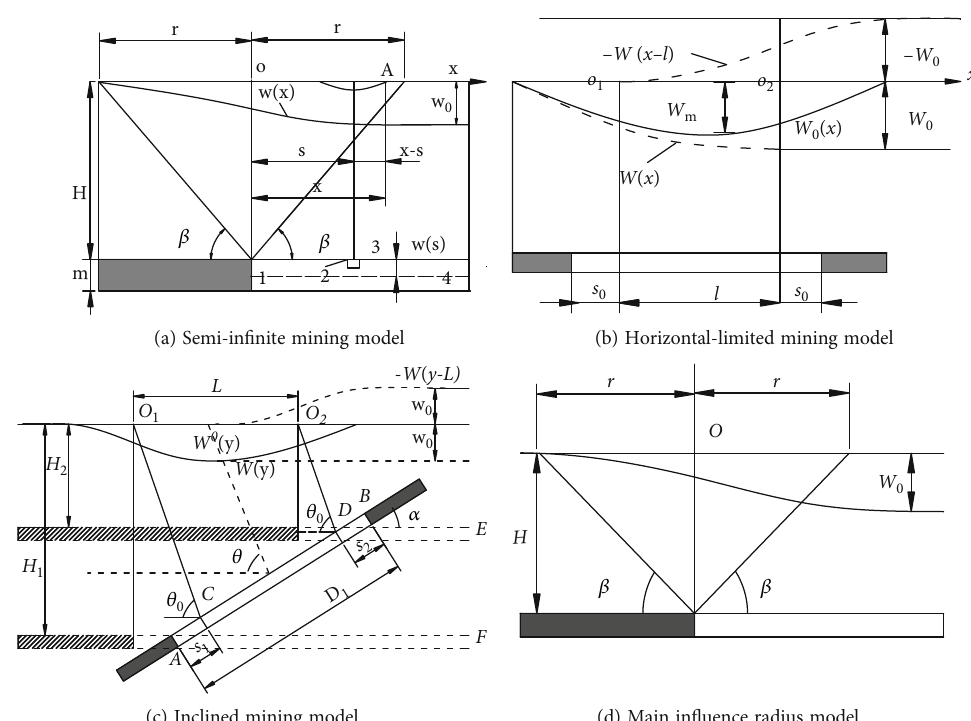
Figure 2: Basic model of mining subsidence probability integration